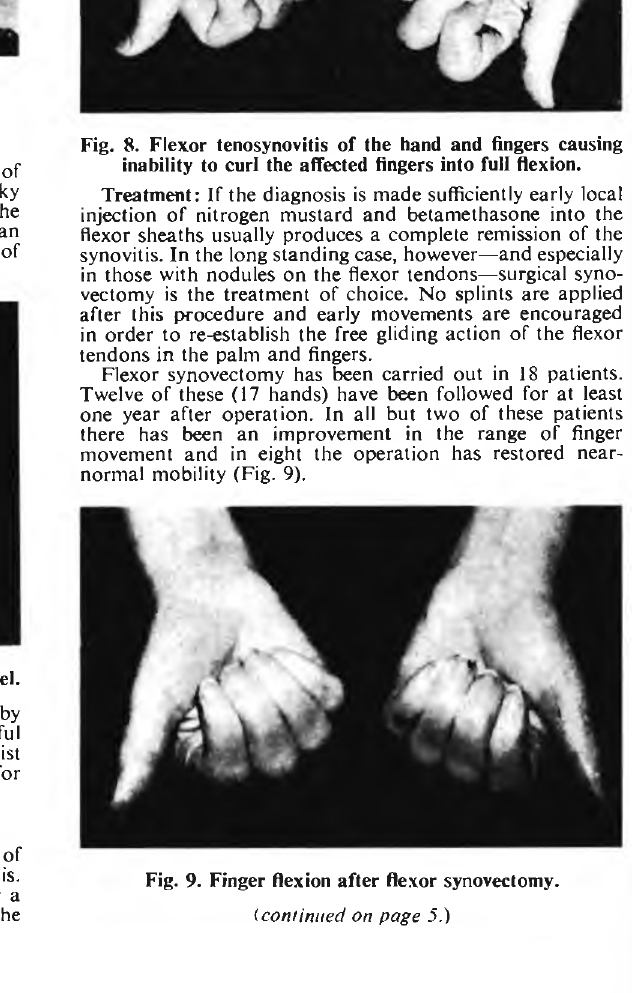
This betrays a failure to examine the hand carefully for a